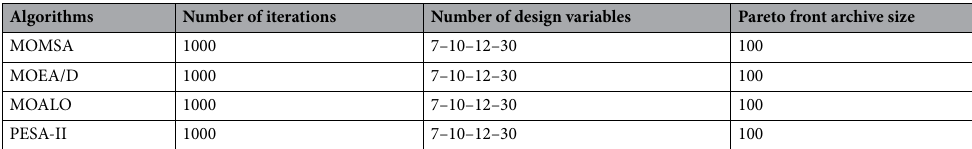
Table 4. Parameter setting of the MOMSA, MOEA/D, MOALO, and PESA-II algorithms in the multi- objective test functions.